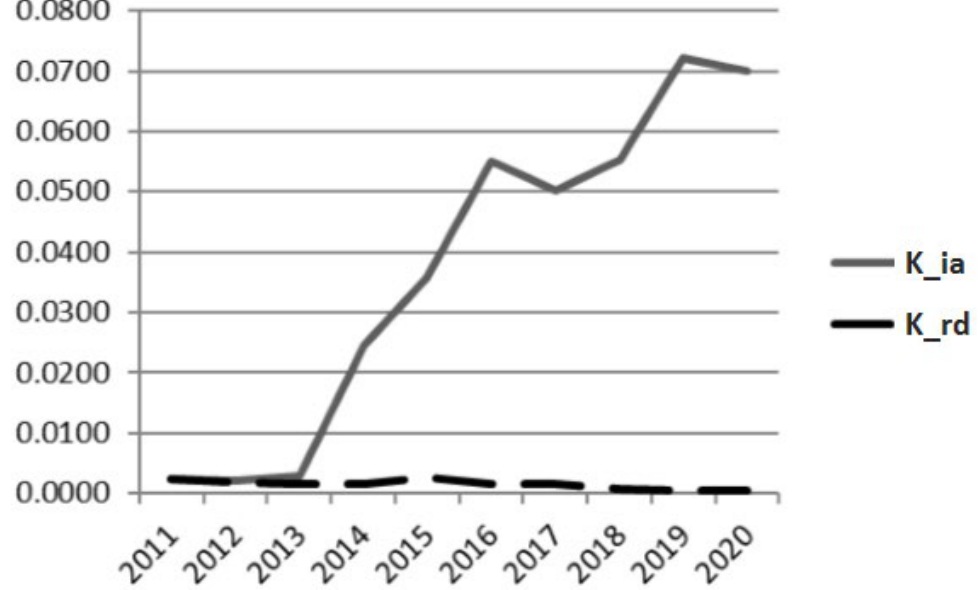
Figure 15. Coefficients of the intangible assets (K_ia) and R&D costs (K_rd) for the PJSC “Norilsk Nickel”.